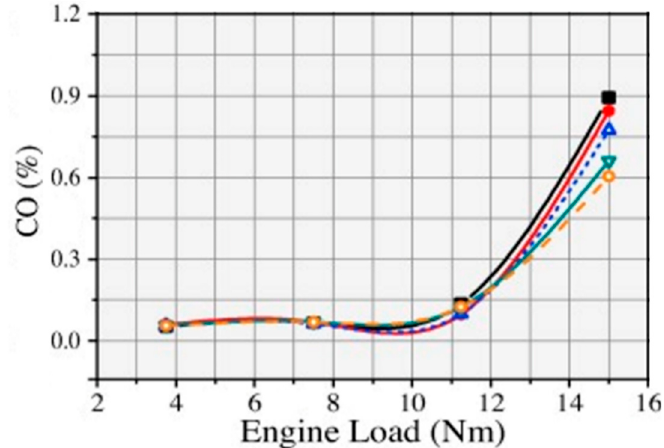
Figure 10. Effects of canola biodiesel blends on CO emissions (adapted with permission from [91], Elsevier, 2017).